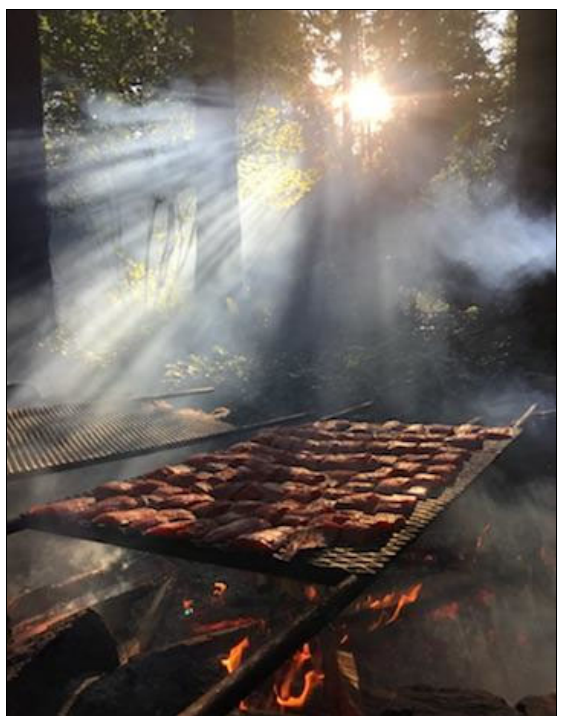
Figure 3. Salmon That Would be Served at the Traditional Dinner for the Gathering Cooking over the